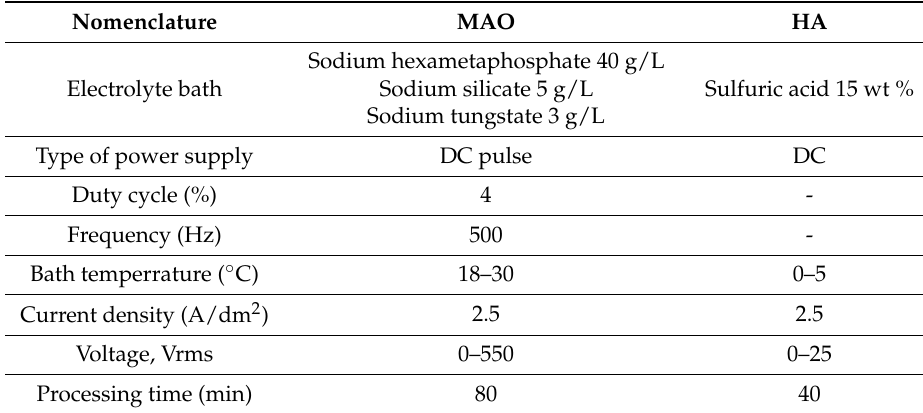
Table 1. Experimental conditions employed for depositing the hard anodization (HA) and micro-arc oxidation (MAO)